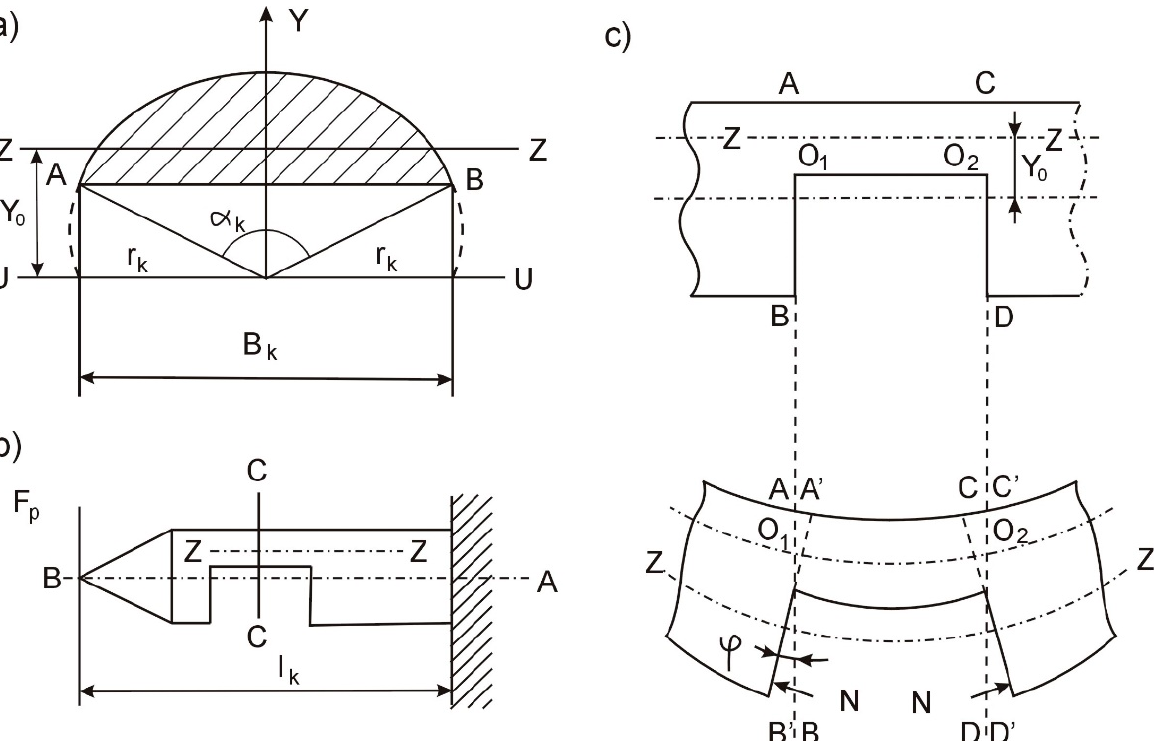
Figure 3. The tailstocks that allow the adjustment of the stiffness: ( a ) shape of the cross-section, ( b ) calculation scheme of the tailstock load, and ( c ) the nature of the deformation of the weakened tailstock.